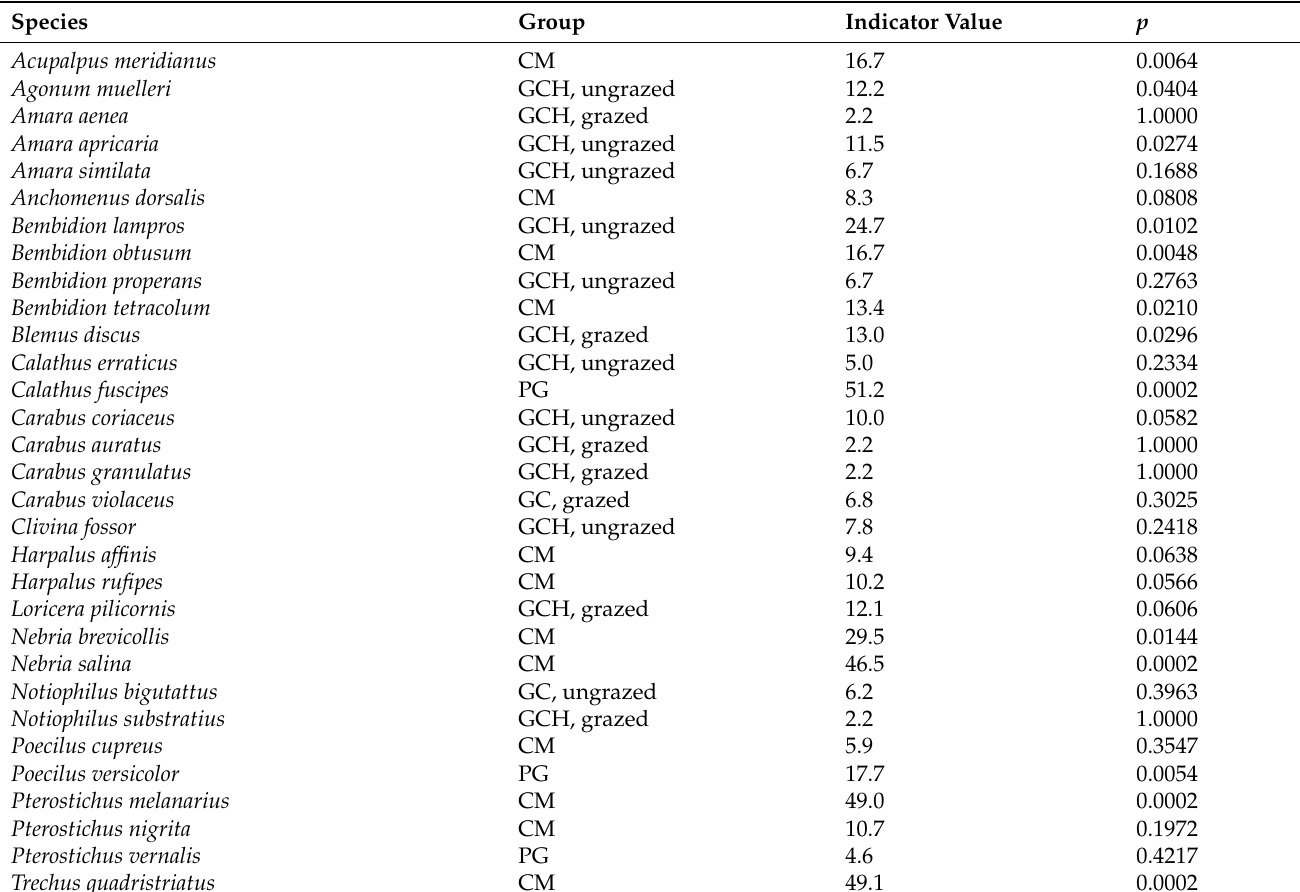
Table A3. Results of indicator species analysis in September (CM: conventional maize, GC: grass– clover, GCH: grass–clover herbs, PG: permanent grasslands).